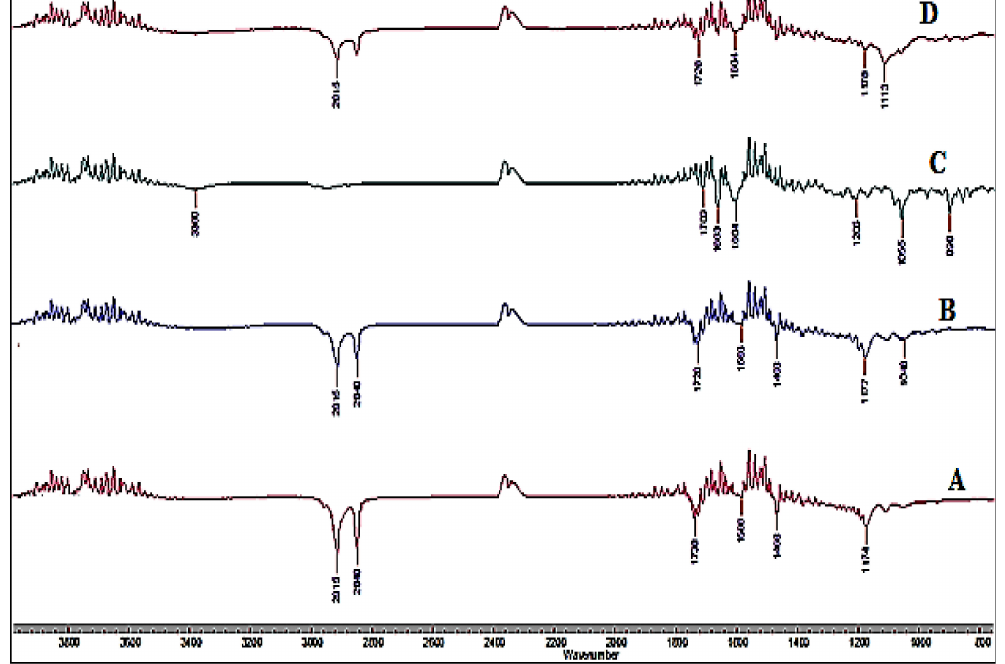
Figure 2. FTIR spectra of ( A ) Compritol ® 888 ATO, ( B ) glyceryl monosterate (GMS), ( C ) triamcinolone acetonide (TA), and ( D ) TA-SLN